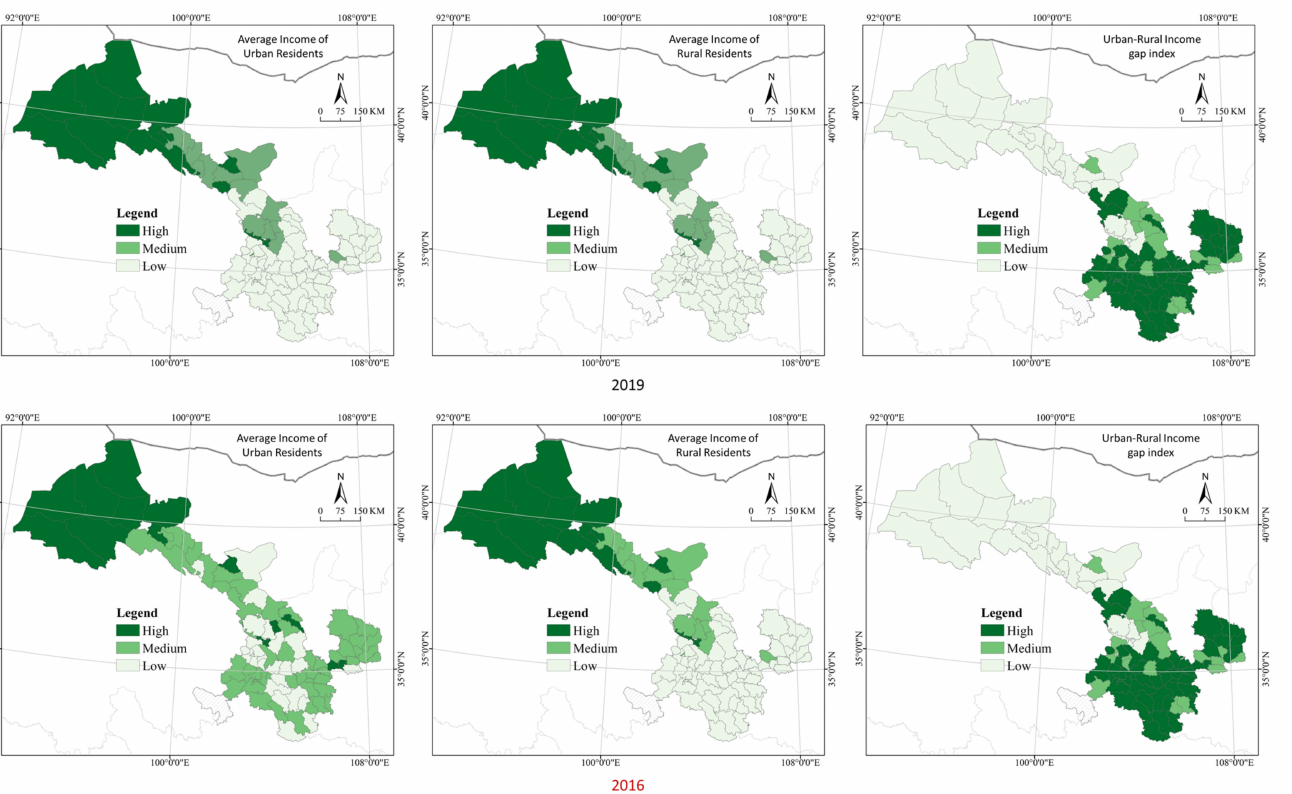
Figure 6. Analysis on Spatial